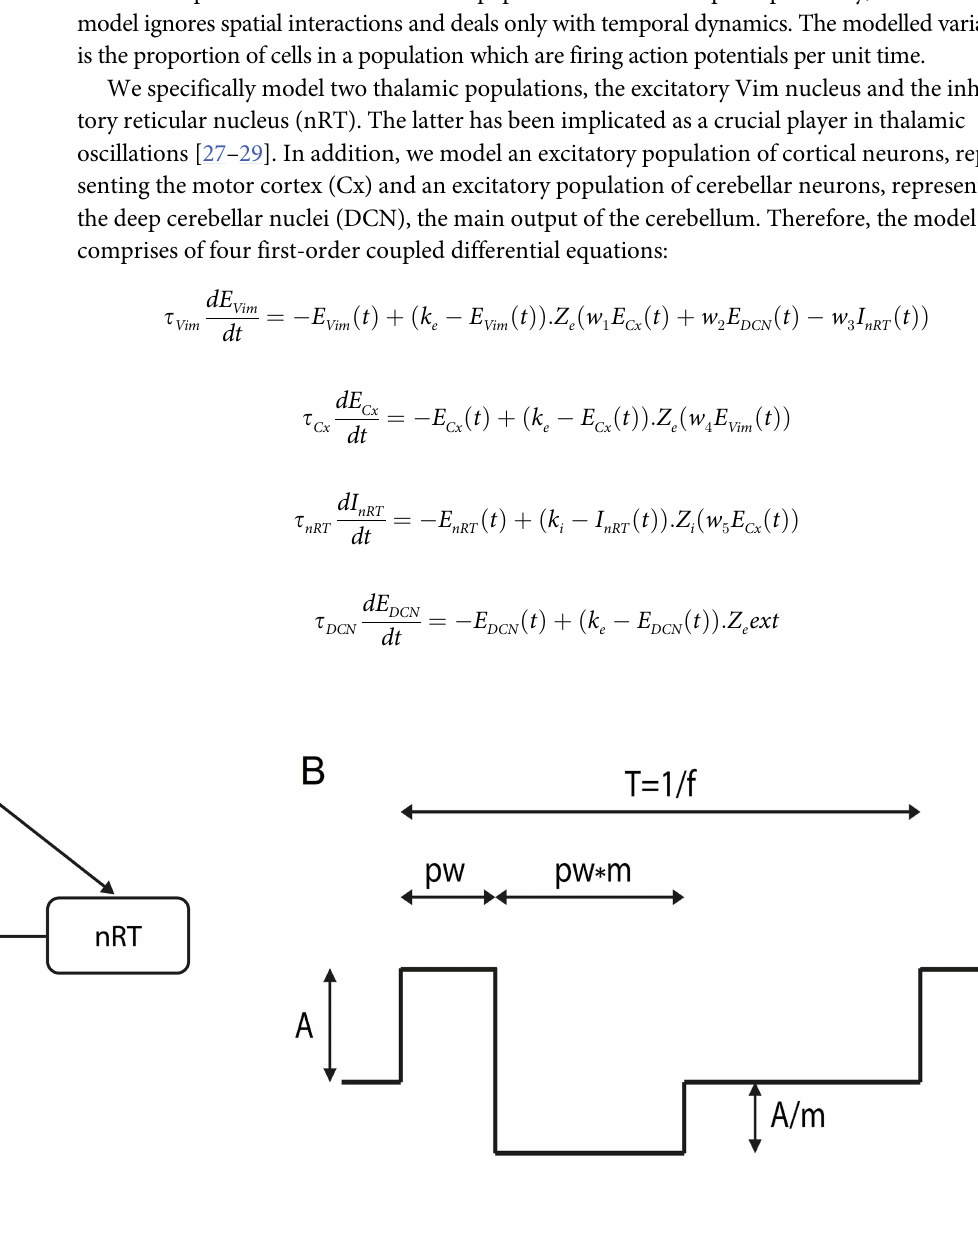
Fig 1. Schematic representation of the network modelled in the study. (A) The model containsfour populations, the motor cortex, the Vim nucleusof the thalamus, the reticular nucleusof the thalamus(nRT) and the deep cerebellarnuclei(DCN). In addition, there are two additional inputs, a constant externalinput in through the cerebellarpopulation and the DBS input into the Vim. (B) The DBS input, unlike the externalinput, is not tonic, but oscillatory over time. We used a biphasicsquare pulse to mirror the pulses used in clinicaltherapy. The waveform is definedby the followingparameters: frequency (f), amplitude(A), pulse width (PW) and the multiple for the